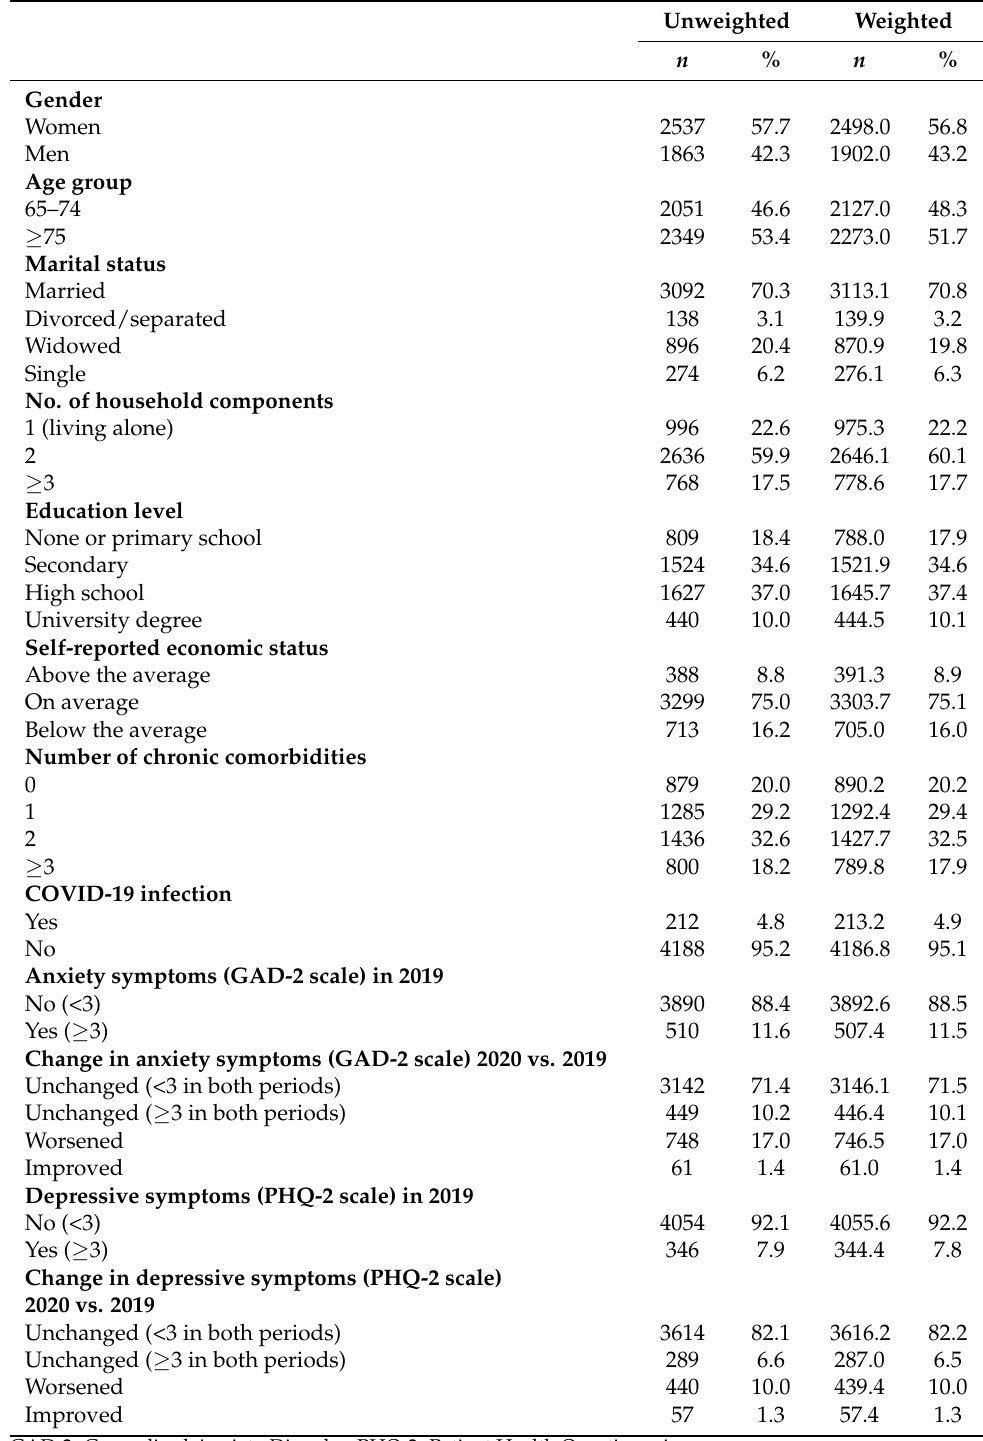
Table 1. Distribution of the overall study population ( n = 4400) according to sociodemographic charac- teristics, number of chronic diseases, self-reported COVID-19 infection, and mental health indicators.